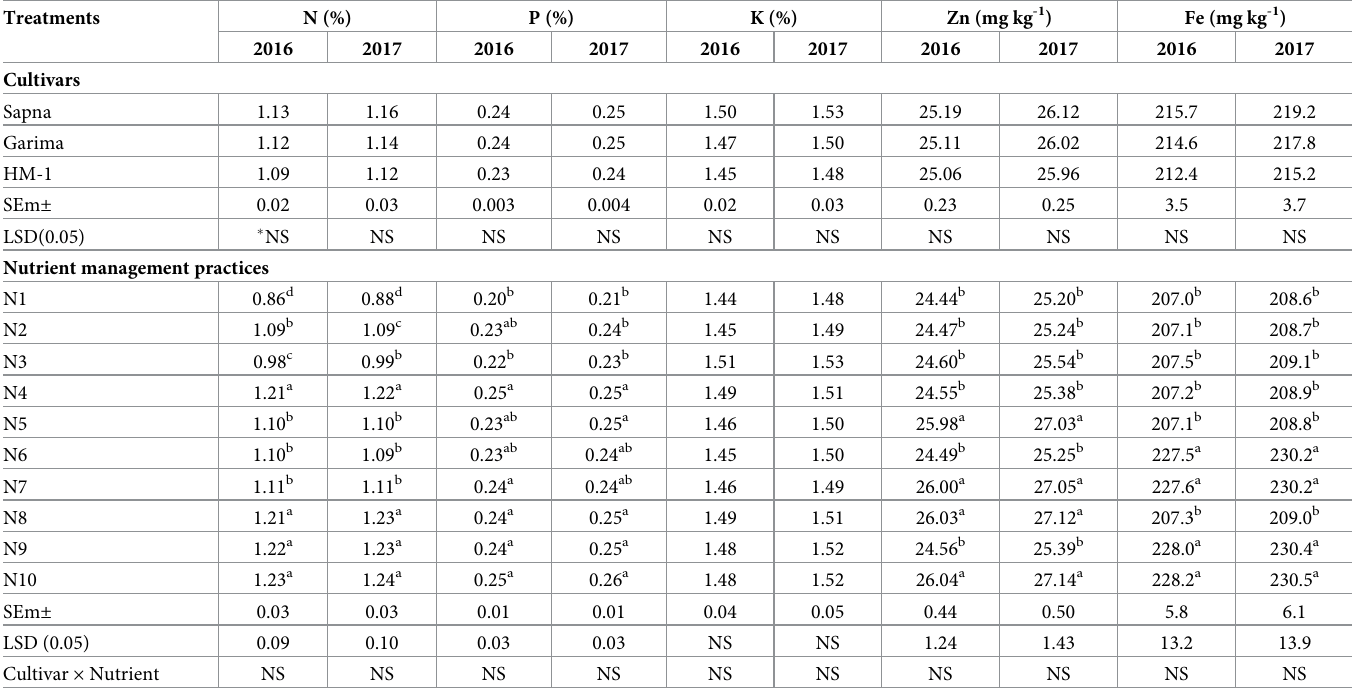
Table 2. Nutrient content in stover of lentil cultivars under different nutrient management levels.